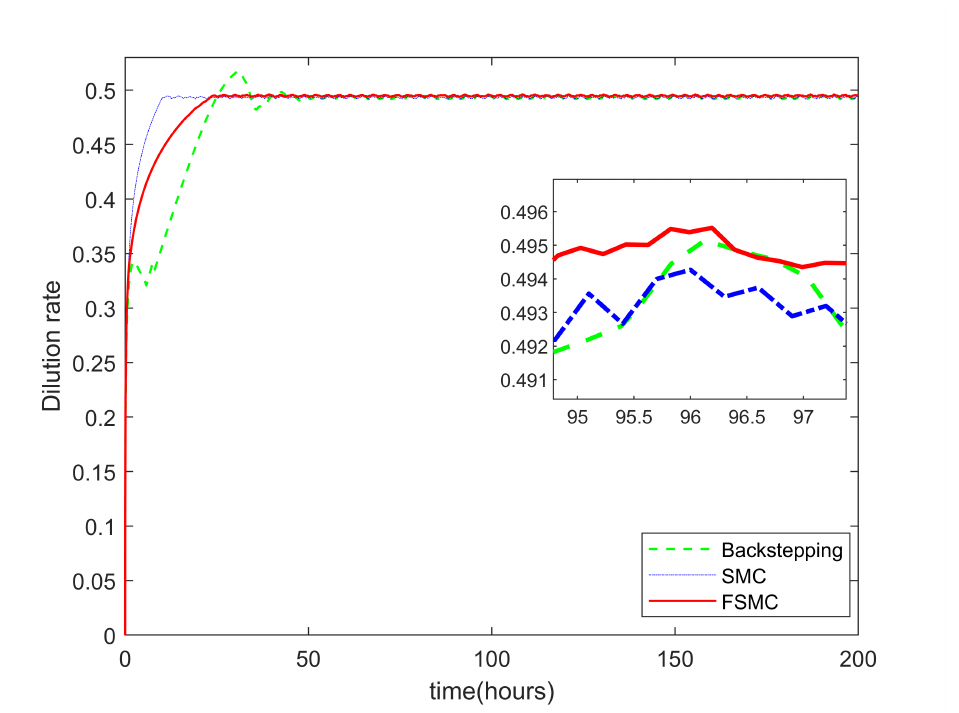
Figure 12. Total